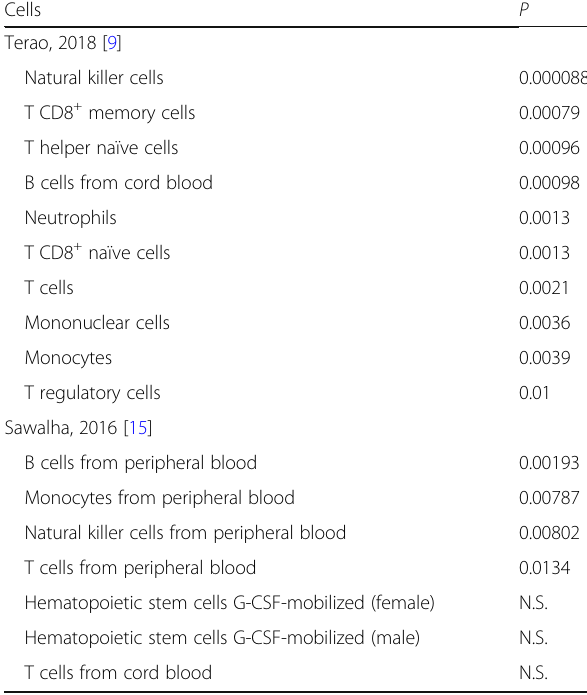
Table 2 Enhancer enrichment analyses of TAK